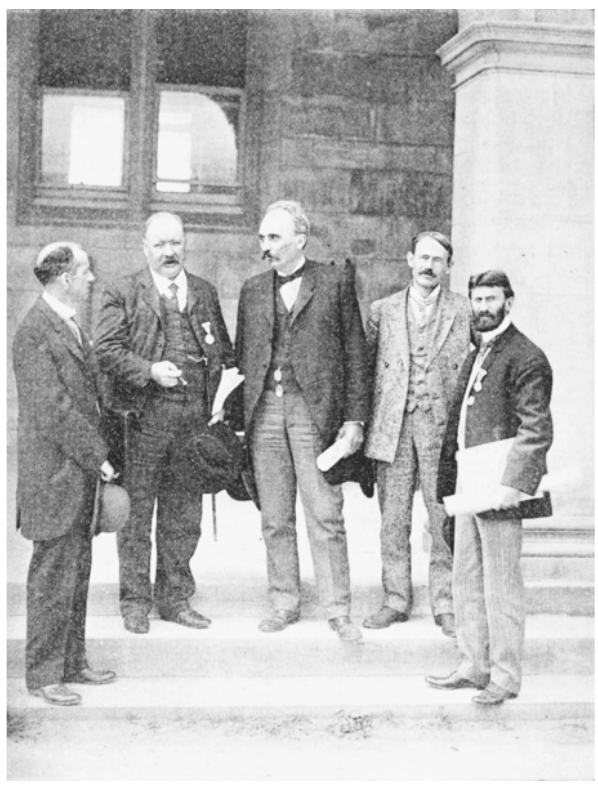
Figure 1. Arrhenius at the 1904 St. Louis Congress. To his left, the American meteorologist Abbott Rotch and, to the far right, the American geophysicist Louis Bauer. Source: Popular Science Monthly Vol. 66